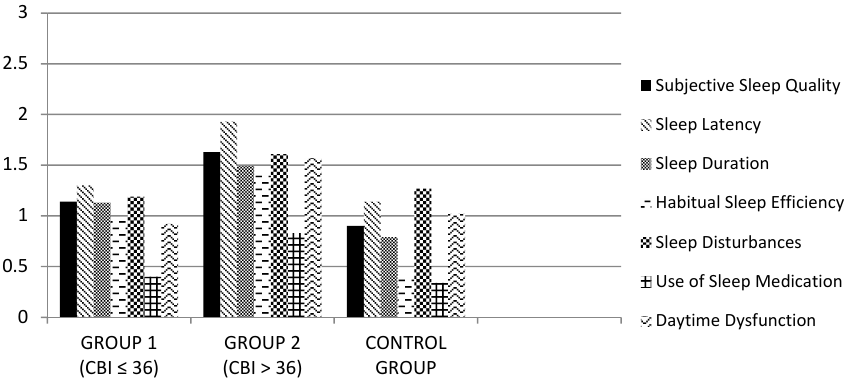
Figure 2. Mean scores of PSQI subscales in the family caregiver groups and non-caregiver controls.